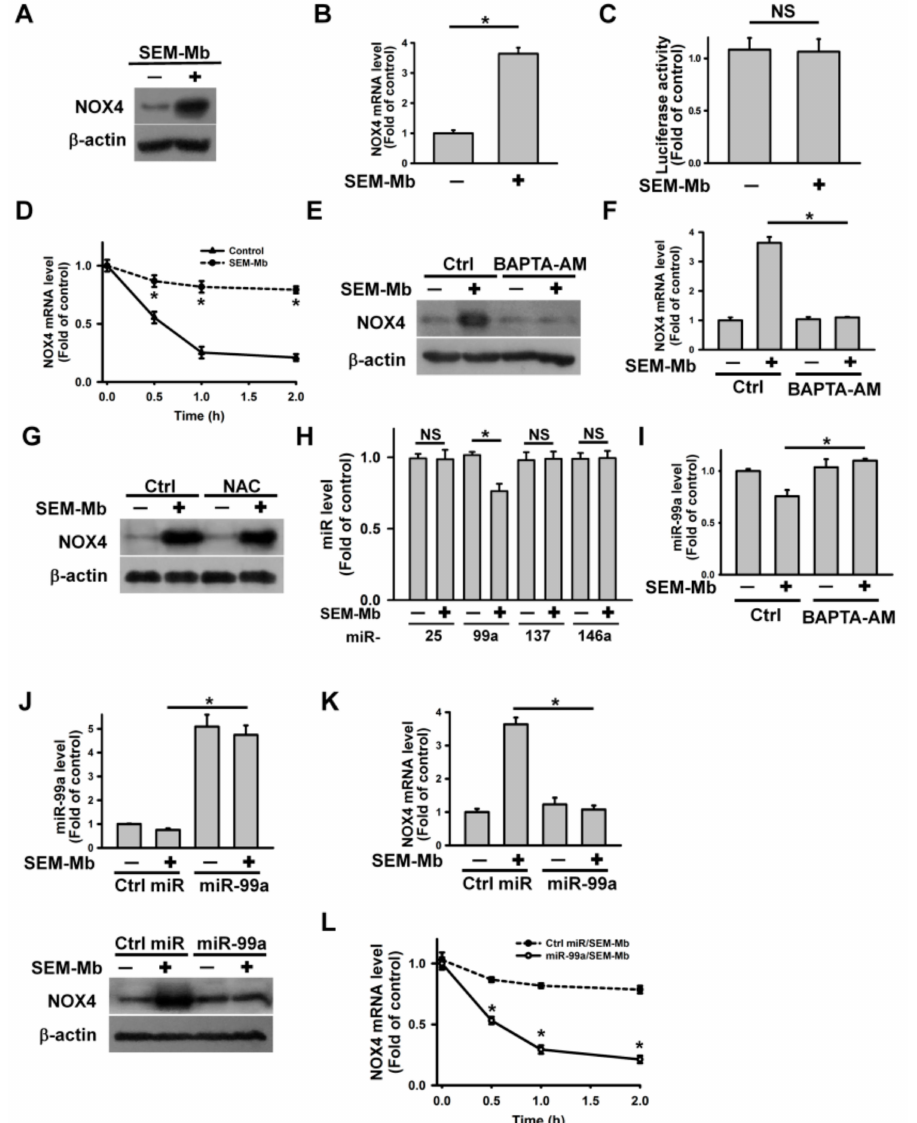
Figure 2. SEM-Mb treatment increased NOX4 expression in U937 cells. U937 cells were directly treated with 1.5 µ M SEM-Mb for 24 h or pre-treated with 10 µ M BAPTA-AM or 2 mM NAC for 1 h and then incubated with 1.5 µ M SEM-Mb for 24 h. ( A ) SEM-Mb induced NOX4 upregula- tion. ( B ) Detecting the transcription of NOX4 mRNA using qRT-PCR. The values represent av- erages of three independent experiments with triplicate measurements (mean ± SD, * p < 0.05). ( C ) Effect of SEM-Mb on the luciferase activity of NOX4 promoter. After transfection with pGL3- NOX4 for 24 h, the transfected cells were treated with 1.5 µ M SEM-Mb for 24 h and then harvested for measuring luciferase activity. The data represent averages of three independent experiments with triplicate measurements (mean ± SD, NS, not statistically significant). ( D ) Effect of SEM-Mb treatment on NOX4 mRNA stability. Cells were treated with or without 1.5 µ M SEM-Mb for 24